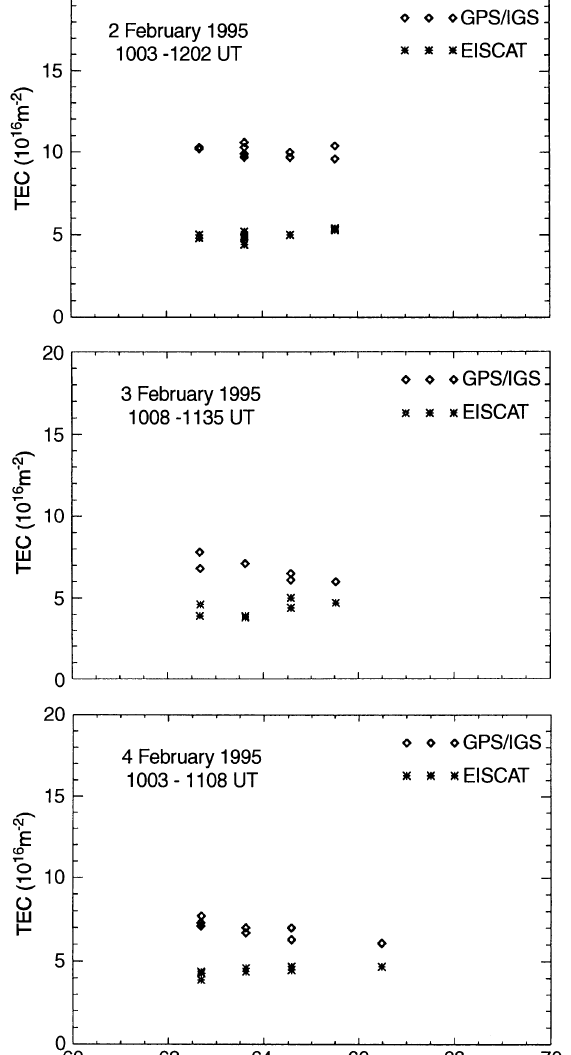
derived from TEC maps. When constructing the maps, the control data were excluded. As Fig. 4 demonstrates, the RMS error for TEC (cid:55) in March 1995 is in the order of 2 (cid:93) 10 (cid:49)(cid:54) m (cid:126)(cid:50) . This result is representative also for